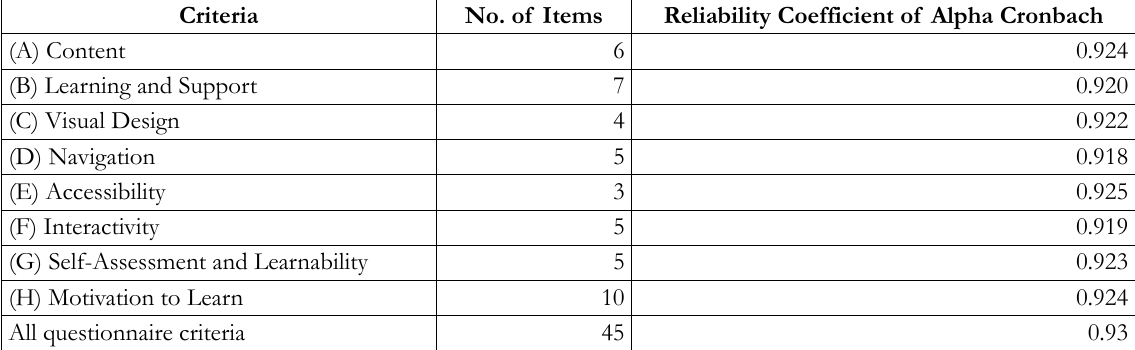
Table 4. Cronbach’s alpha coefficients of reliability for the questionnaire on eight criteria